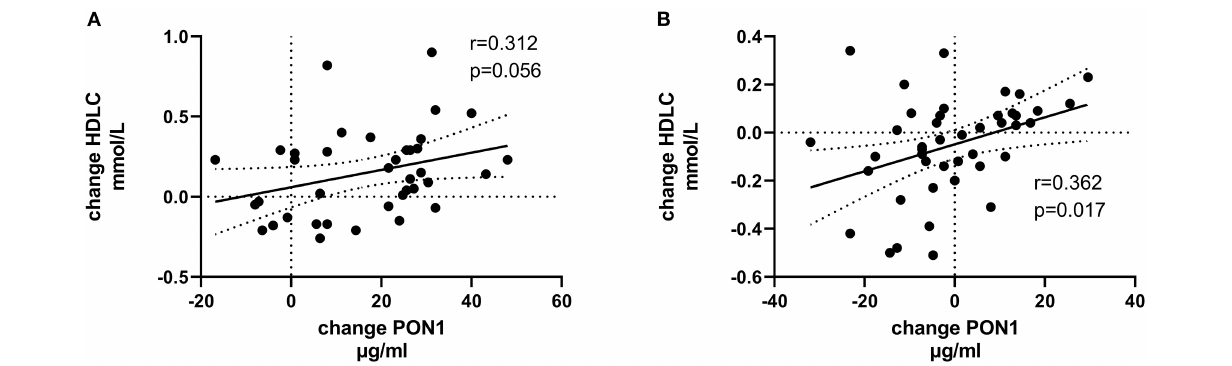
correlation of the change in PON1 mass with these in the dialysis group ( p = 0.998, 0.342, respectively). PON1 Q192R phenotype frequency was not different between the dialysis and KT groups ( Supplementary Table 1 ,